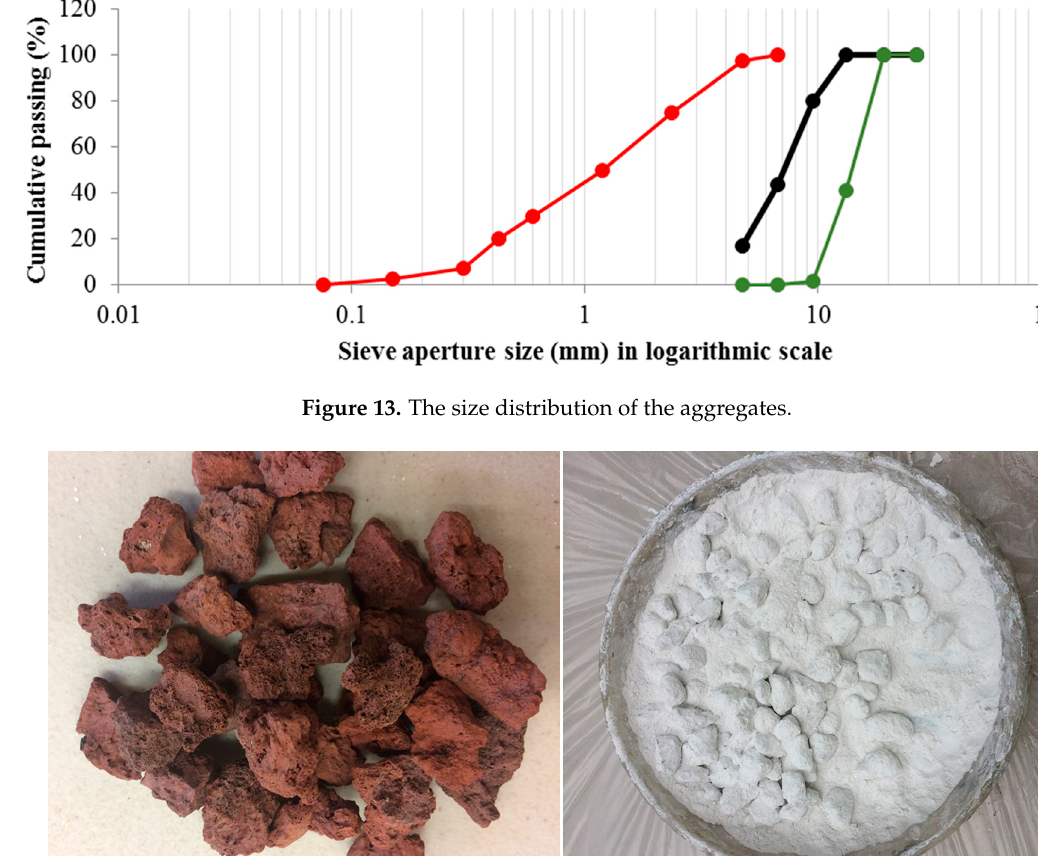
Figure 14. Scoria before and after coating.